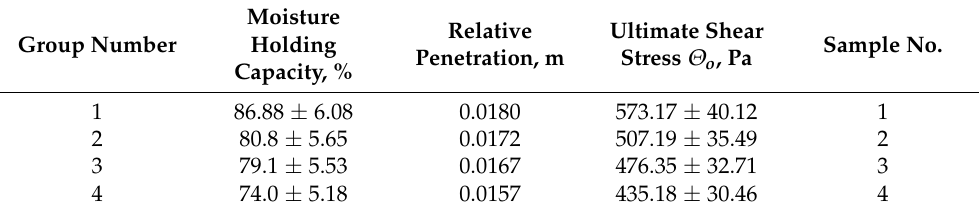
Table 11. Rheology, structural, and mechanical properties of curd products. Moisture Hold- Group Number